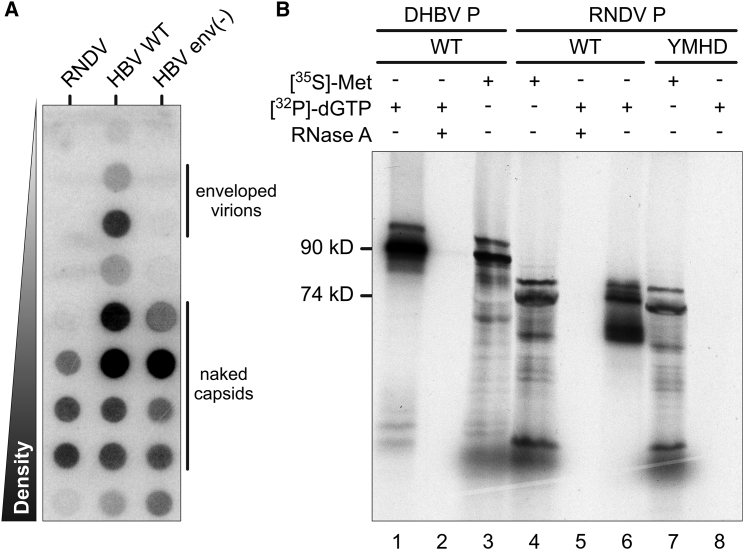
Virological Assays(A) Release of naked capsids from RNDV-transfected cells. HuH-7 cells were transfected with expression plasmids containing terminally redundant genomes of RNDV, HBV, or HBV env(−), an envelope protein-deficient HBV mutant. Cell culture supernatants were subjected to CsCl density gradient centrifugation followed by detection of viral DNA in gradient fractions by DNA-dot blot hybridization. Similar results were obtained in the HEK cell line HEK293T and in the rainbow trout gonad cell line RTG-2 (data not shown).(B) P priming assays. RNDV and duck hepatitis B virus (DHBV) wild-type (WT) P proteins produced in a coupled in vitro transcription/translation system were incubated with [α-32P]dGTP and subjected to SDS-PAGE followed by autoradiography (lanes 1 and 6). To demonstrate template dependency of the priming reaction, RNase A digests were performed prior to incubation with [α-32P]dGTP (lanes 2 and 5). An RNDV YMDD-motif mutant in P was included to show dependency of the priming reaction on an intact RT domain (YMHD; lane 8). As control for proper protein production, P proteins were metabolically radiolabeled with [35S]methionine without addition of [α-32P]dGTP (lanes 3, 4, and 7).